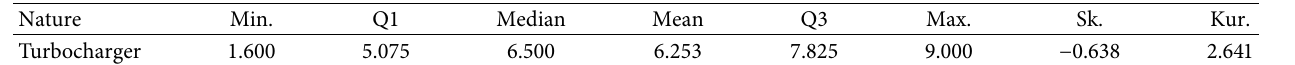
Table 9: Descriptive statistics for turbocharger data.